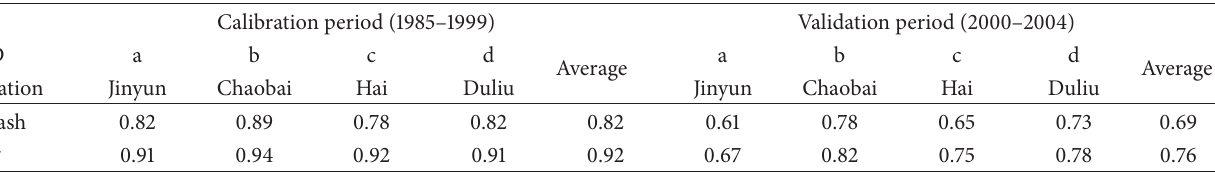
Figure 10: Calibration of the model. Comparison between simulated and observed streamflow at the four stations: Jiyun River (a), Chaobai River (b), Hai River (c), and Duliu River (d). Table 3: Correlations at the four observed stations during calibration and validation periods.